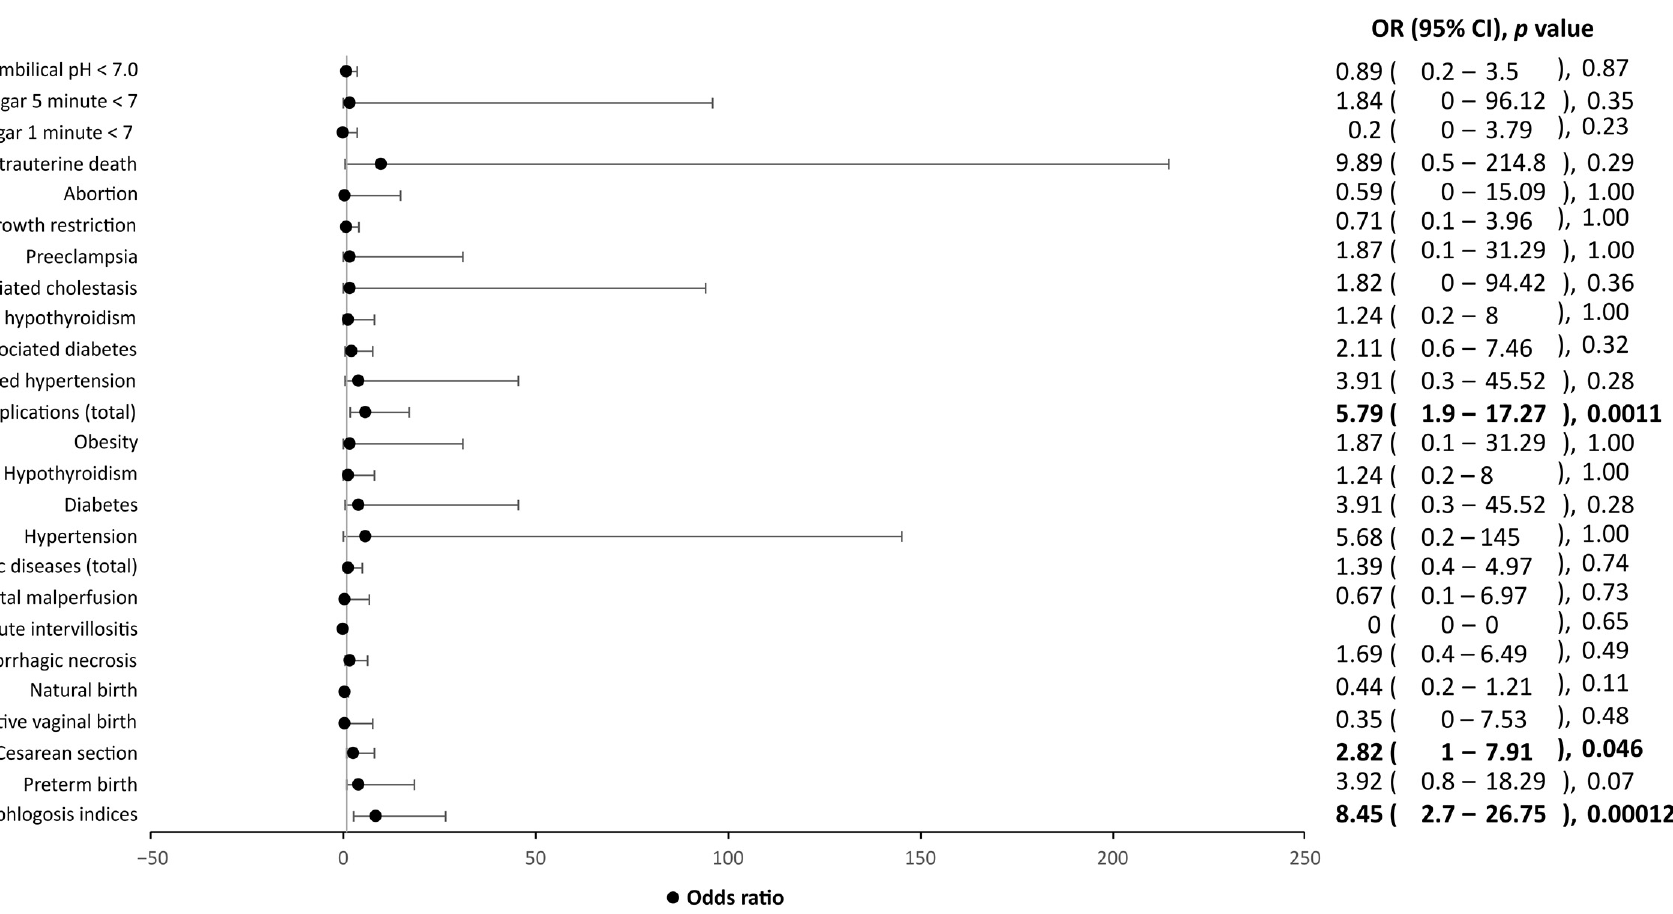
Figure 2. Influence of clinical factors, including chronic diseases, pregnancy-associated complications and Apgar score, on symptomatic SARS-CoV-2-positive mothers and their children, as compared to asymptomatic SARS-CoV-2 mothers and their children. OR, odds ratio; CI, confidence interval. Values in bold indicate statistical significance, as the level of statistical significance was set to p < 0.05.